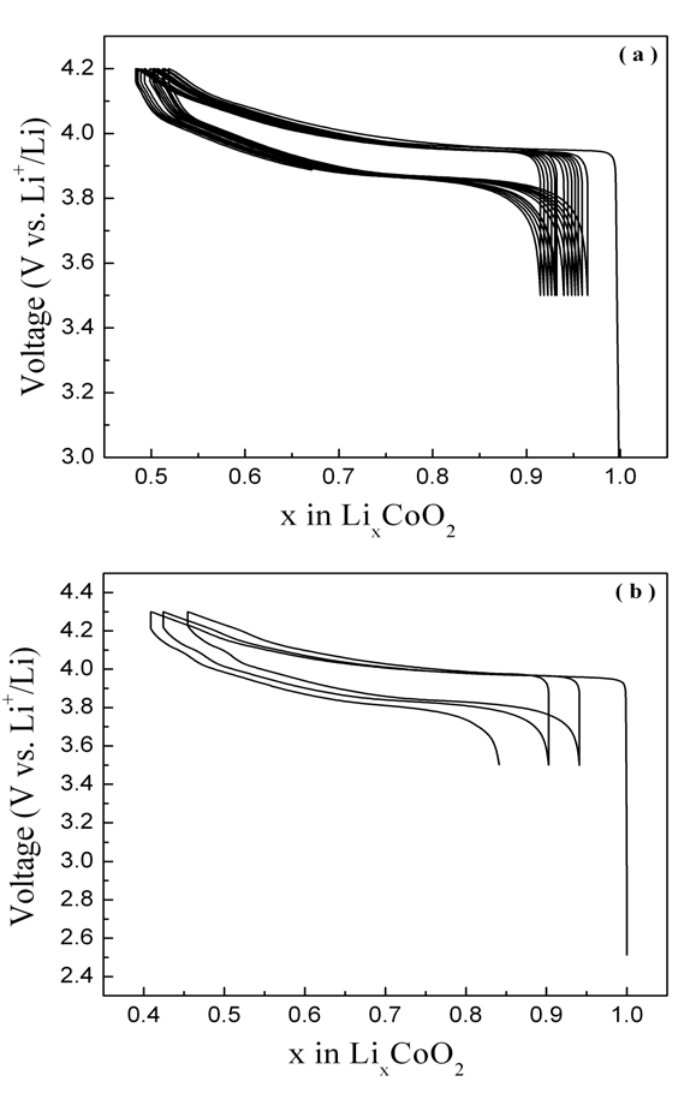
Figure 5. The voltage-composition curve for a Li/Li x CoO 2 -700 cell cycled galvanostatically at 1 Li/5 h rate between the voltage window (a) 3.5 - 4.2 V and (b) 3.5 - 4.3 V at room temperature (~30